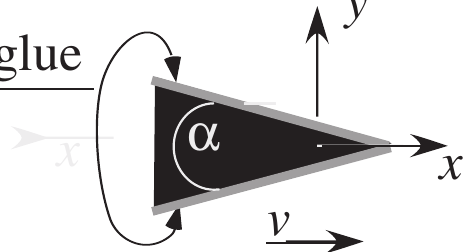
Figure 2. The black angle is the “hole” B t α = α ∗ ). S B is obtained by identifying—at each t —the upper gray ray, y = − tg ( α /2 )( x − vt ) , y > 0, with the lower one, y = tg ( α /2 )( x − vt ) , y <